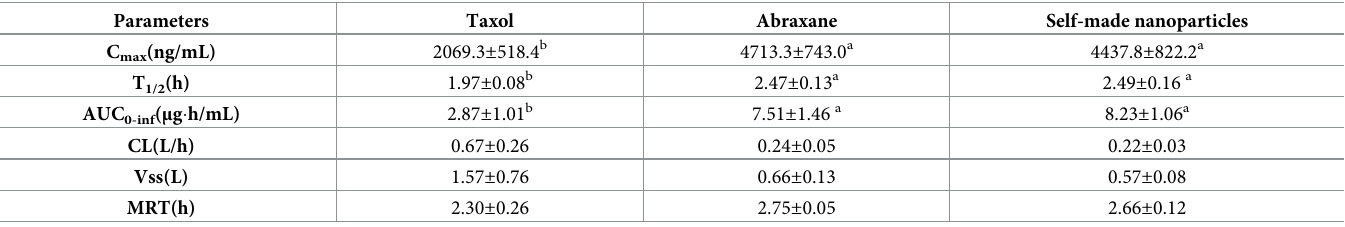
Table 3. Primary pharmacokinetic parameters of paclitaxel in rats after intravenous administration of Taxol, Abraxane, or self-made nanoparticles at a paclitaxel dose of 7mg/kg ( n =